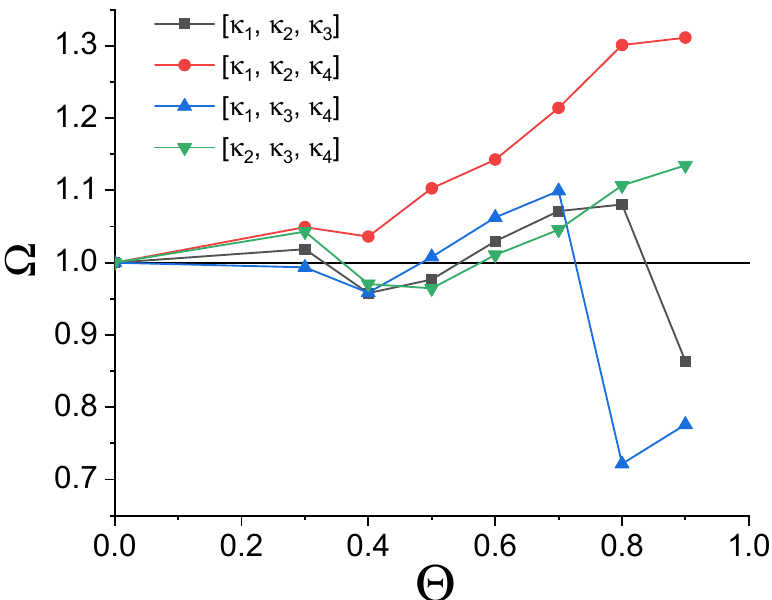
Figure 10. The dependence of the integral separability index Ω vs. the threshold value Θ . The horizontal line indicates the integral separability values determined for the input data. Threshold Θ = 0 corresponds to unprocessed input data.